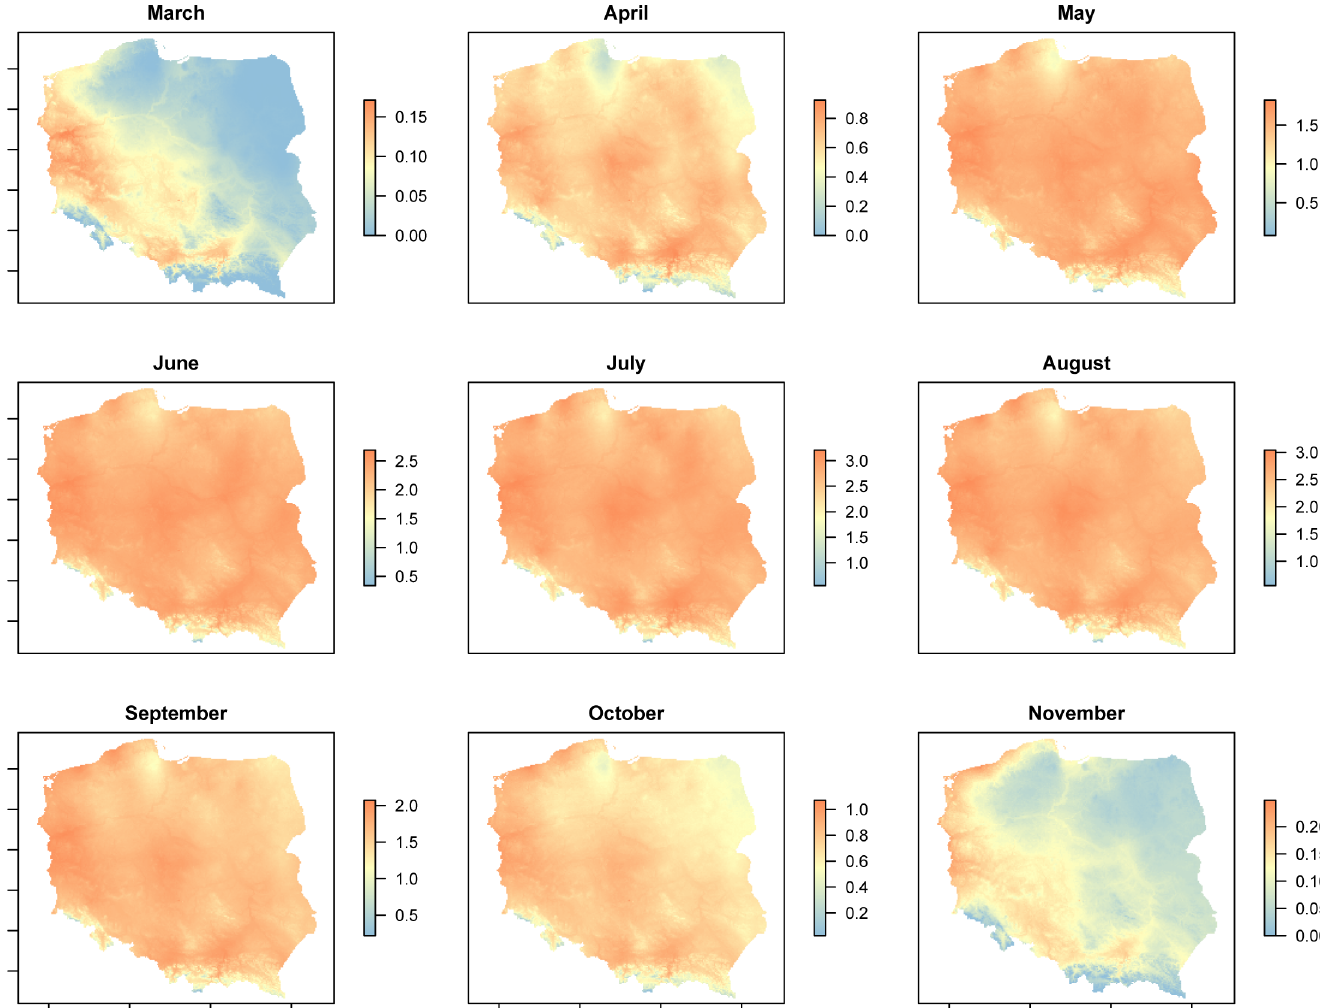
Fig 5. Spatial variation in intrinsic growth rate for Aceria tosichella lineage MT-8, predicted from fundamental thermal niche using mean monthly temperatures.